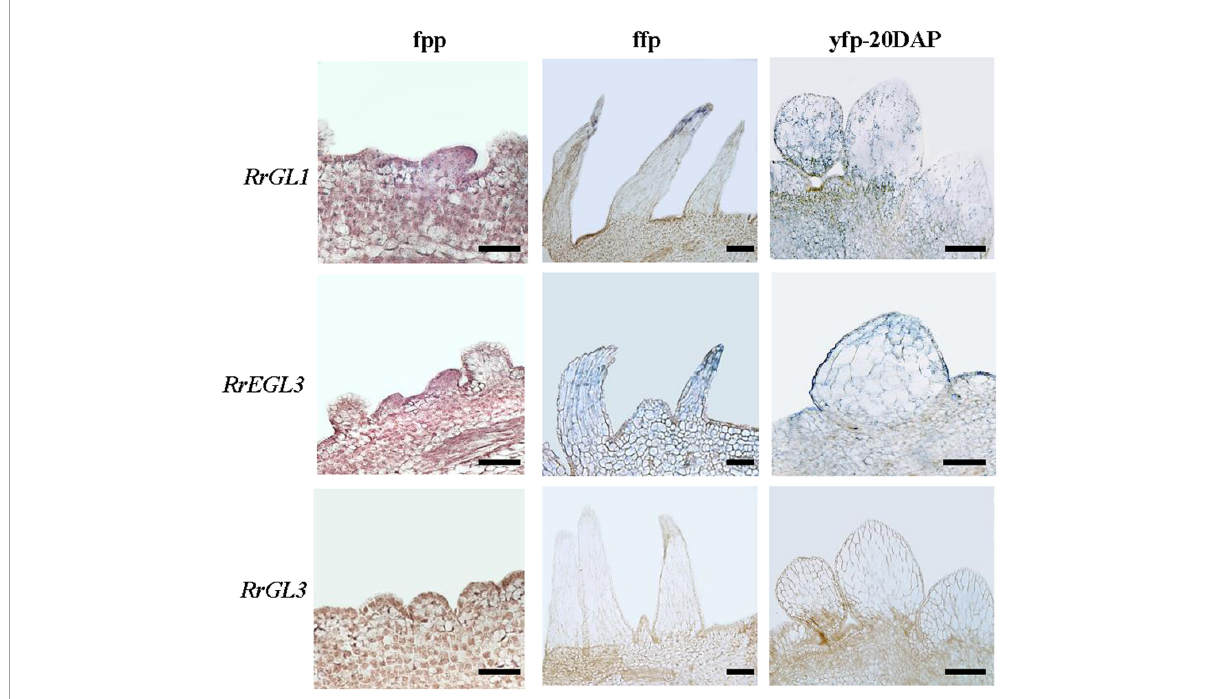
FIGURE7 RrGL1 and RrEGL3 highly expressed at the early stage of fruit prickles formation. In situ hybridization testing the expression pattern of RrGL1 , RrEGL3 , and RrGL3 in fruit prickle primordium (ffp), flagelliform fruit prickle (ffp), and young fruit prickle on 20 DAP fruit (yfp-20 DAP). Bar = 200 µ m.